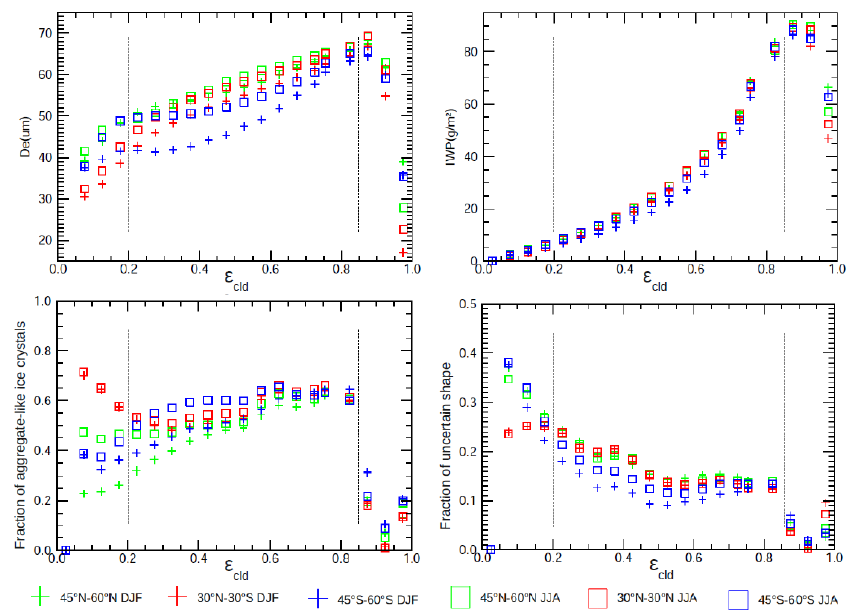
Fig. 4. Bulk microphysical properties as function of cloud emissivity, averaged over the period 2003–2009. Crosses and squares represent averages over boreal winter and over boreal summer, respectively. Green symbols are for NH midlatitudes, red for the tropics and blue for SH midlatitudes. The vertical lines represent the emissivity boundaries between which the microphysical property retrieval is applied.